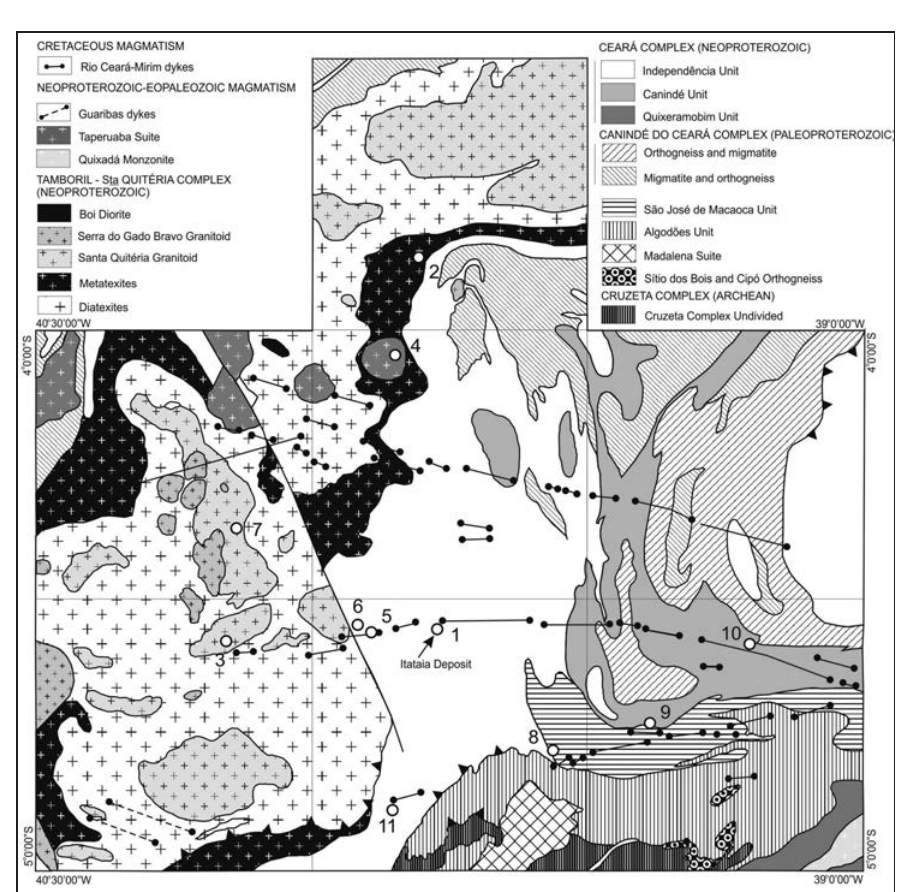
Figure 3 - Geological map with location of the Itataia U-P deposit (1), and of the Mandacarú (2), Serrotes Baixos (3), and Taperuaba prospects (4). Other U-P occurrences (5, 6, 7, 8, 9, 10) and barren albitite (11), mapped during the Phosphate Brazil Project (compiled from Cavalcanti and Bessa 2011) are also shown.